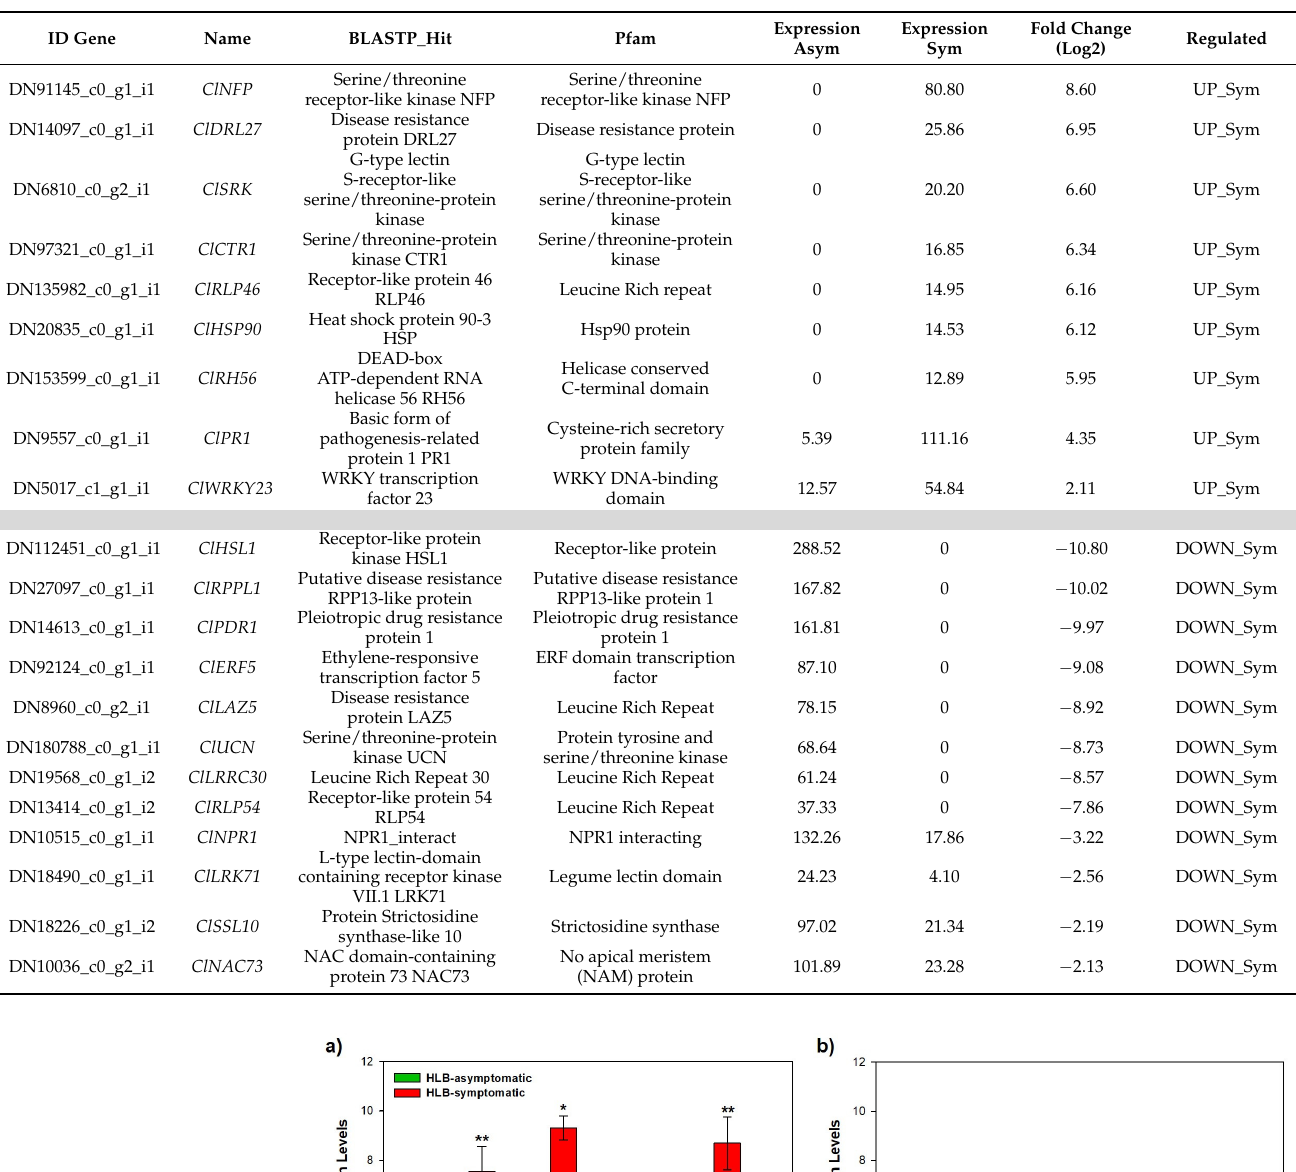
Table 1. Genes associated with signaling and disease resistance in response to HLB infection in the Persian lime transcriptome.